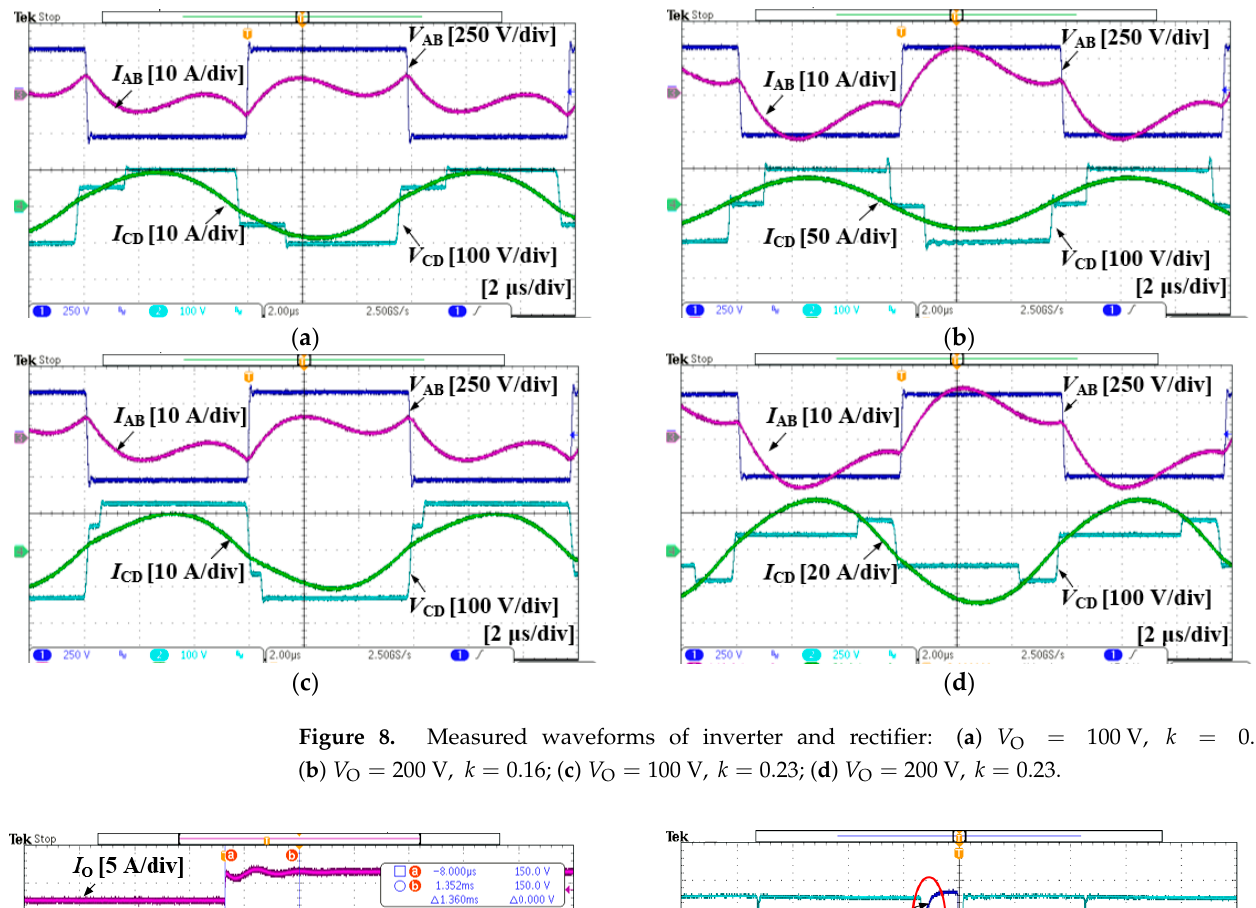
Figure 7. Photo of the prototype. L 1 : Transmitter coil ; L 2 : Receiver coil; C 1 , C F : Resonant capacitors on the transmitter side; L F : Resonant inductor on the transmitter side; C 2 : Resonant capacitor on the receiver side; DSP: digital signal processor TMS TMS320F28335.